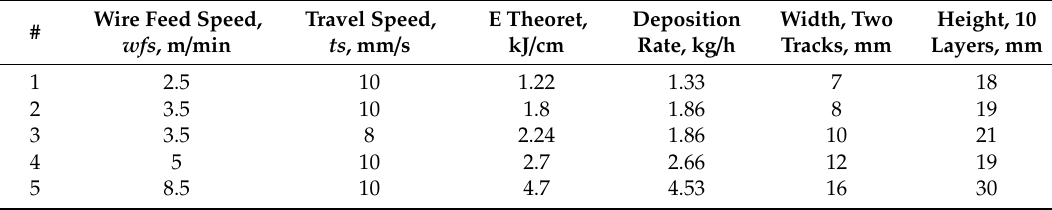
Table 4. Resulting geometry for two-track walls with different parameter-sets and an overlapping of 66% of bead width.